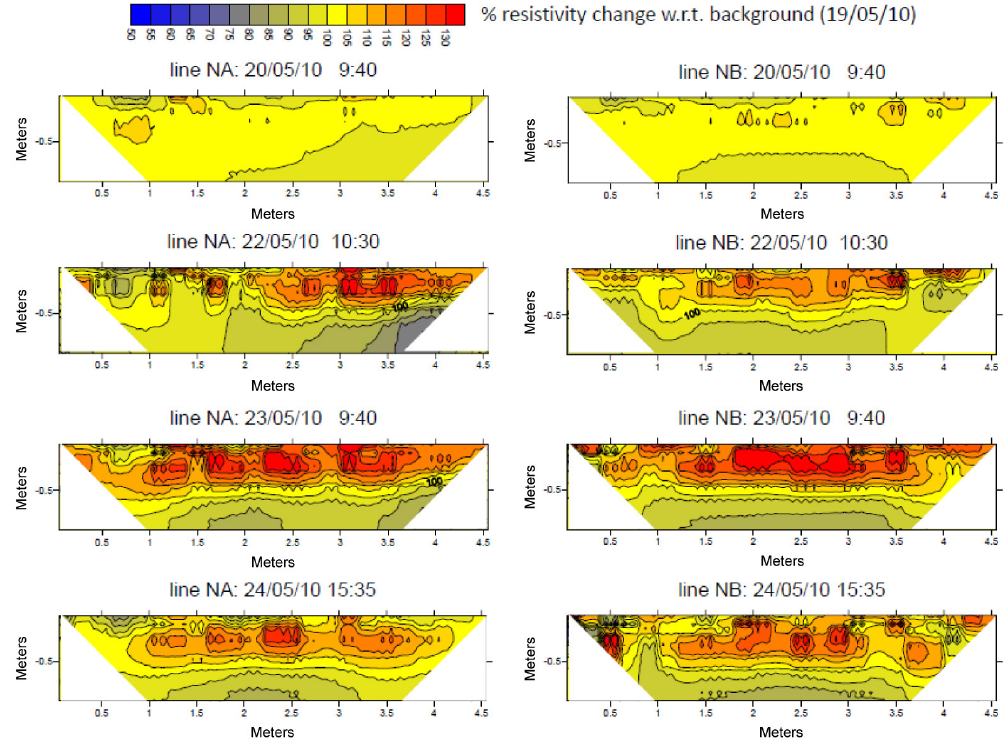
Fig. 6. ERT measurements along lines NA (left panels) and NB (right panels) in the fallow plot at different times. Top to bottom panels: background, after irrigation (22 May 2010, 10:30LT), 1day after irrigation (23 May 2010, 09:40LT), more than 2days after irrigation (24 May 2010, 15:35LT).